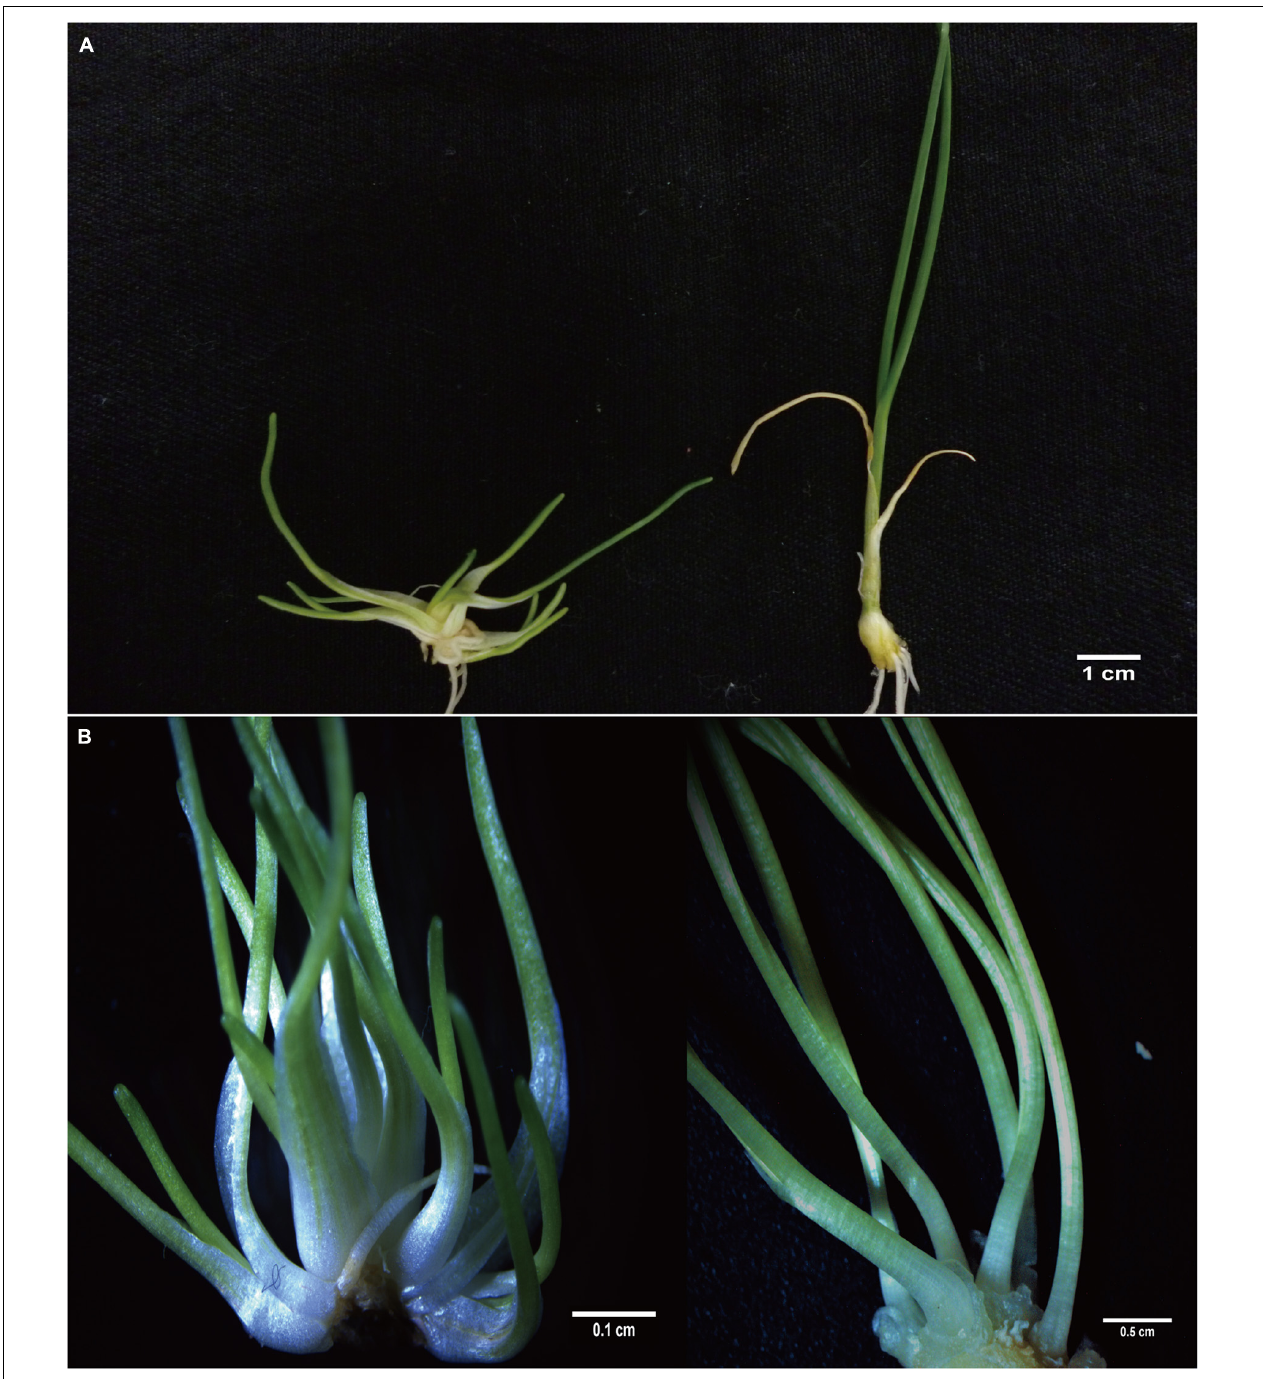
FIGURE 4 | Comparison of plant architecture and growth characteristics of diploid and tetraploid in different regeneration stages. (A) Developed tetraploid (left) and diploid (right) plantlet. (B) Newly regenerated tetraploid (left) and diploid (right)